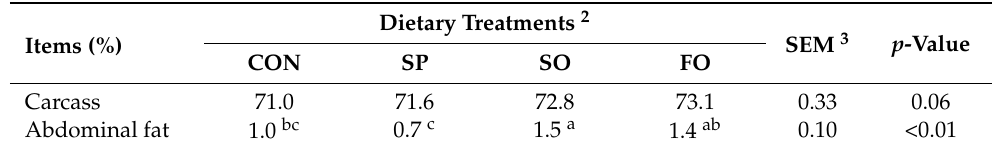
Table 5. Effects of dietary Schizochytrium, salmon oil, and flaxseed oil on carcass characteristics in broiler chickens 1 .